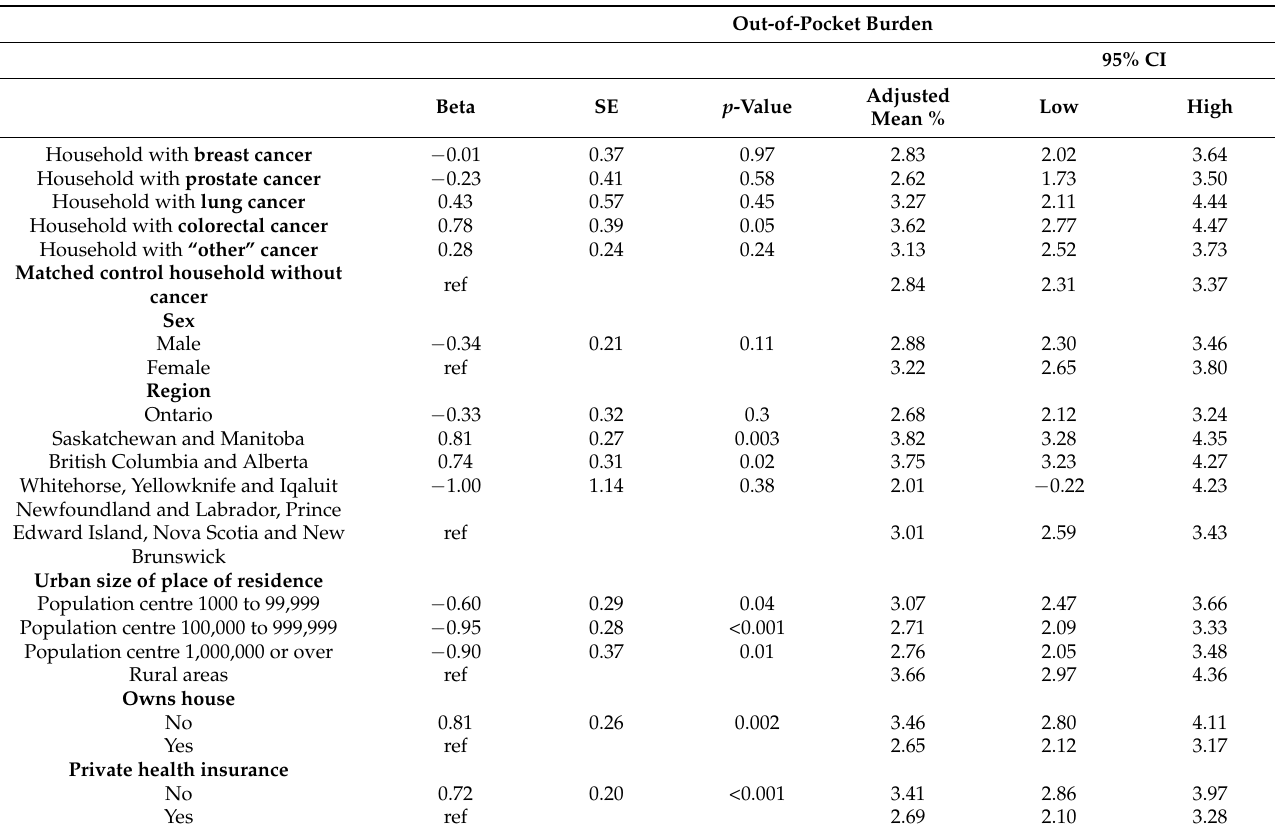
Table 6. Model-adjusted out-of-pocket burden for households with cancer and without cancer, by cancer type.